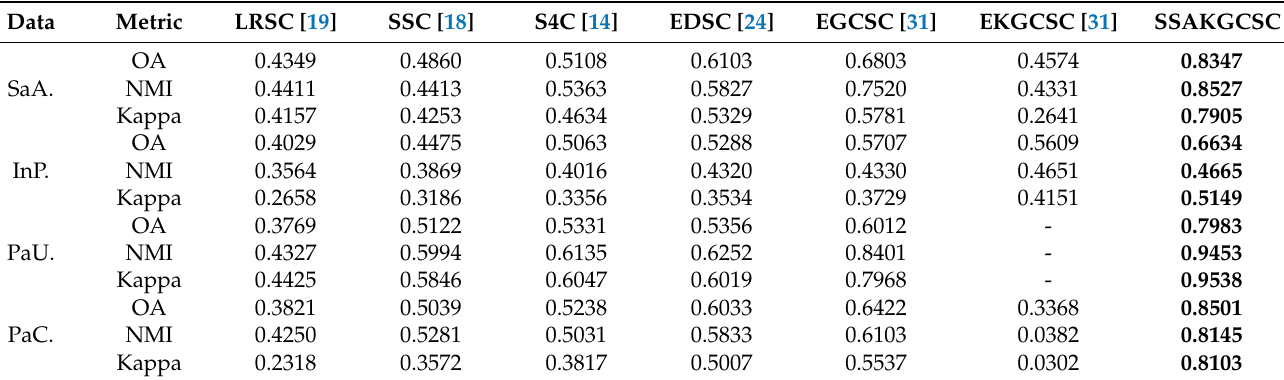
Table 4. Clustering performance of the compared methods on SalinasA, Indian Pines, Pavia Univer- sity, and Pavia Center data sets with salt and pepper noise (the probability is 0.1).